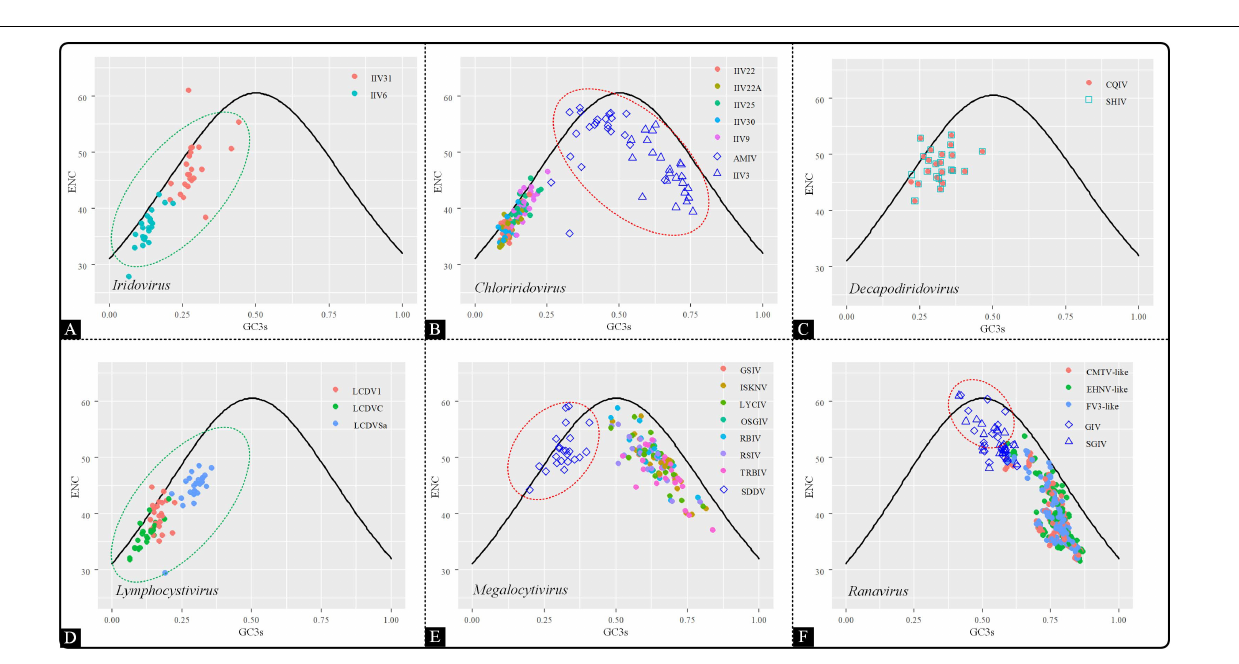
FIGURE 5 | ENC–GC3 plot of 53 Iridoviridae viruses. The solid line indicates the expected curve of ENC vs GC3 only under mutational pressure. Points on or close to the expected curve mean that the bias is caused by mutation pressure, while points below the curve indicate the presence of other influential factors such as natural selection. Green circles suggest a high dispersion degree among points inside the circle, while red circles indicate that points inside the circle have a high degree of dispersion as compared to those outside the circle. (A) Iridovirus , (B) Chloriridovirus , (C) Decapodiridovirus , (D) Lymphocystivirus , (E) Megalocytivirus , and (F)